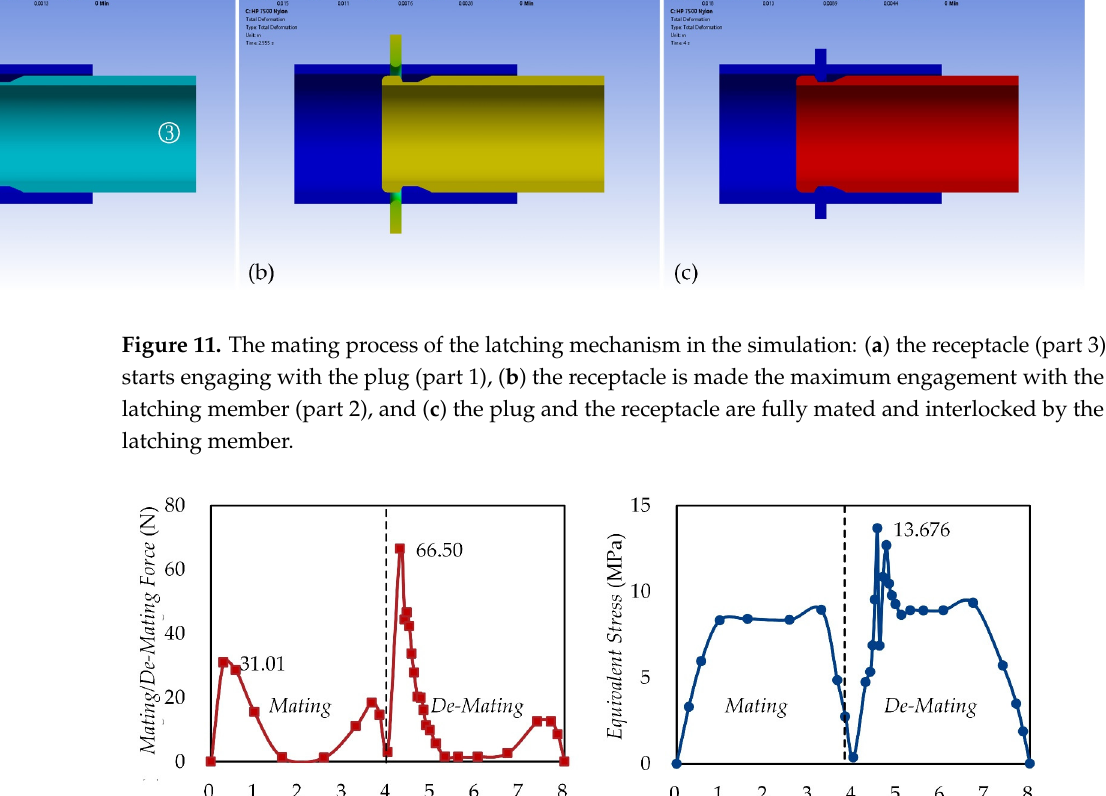
Figure 12. The change curves of ( a ) the mating/de - mating force and ( b ) the equivalent stress of the latching member.